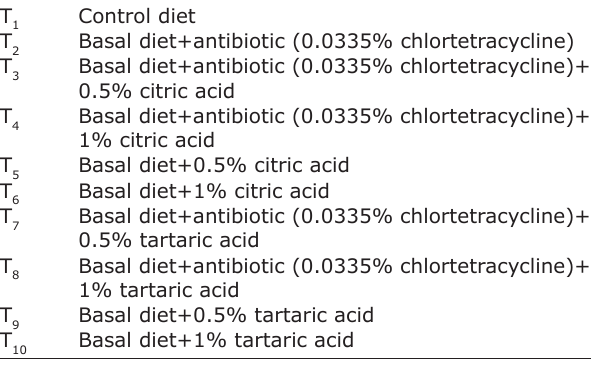
Table 4: Different dietary treatments. Control diet T 1 T